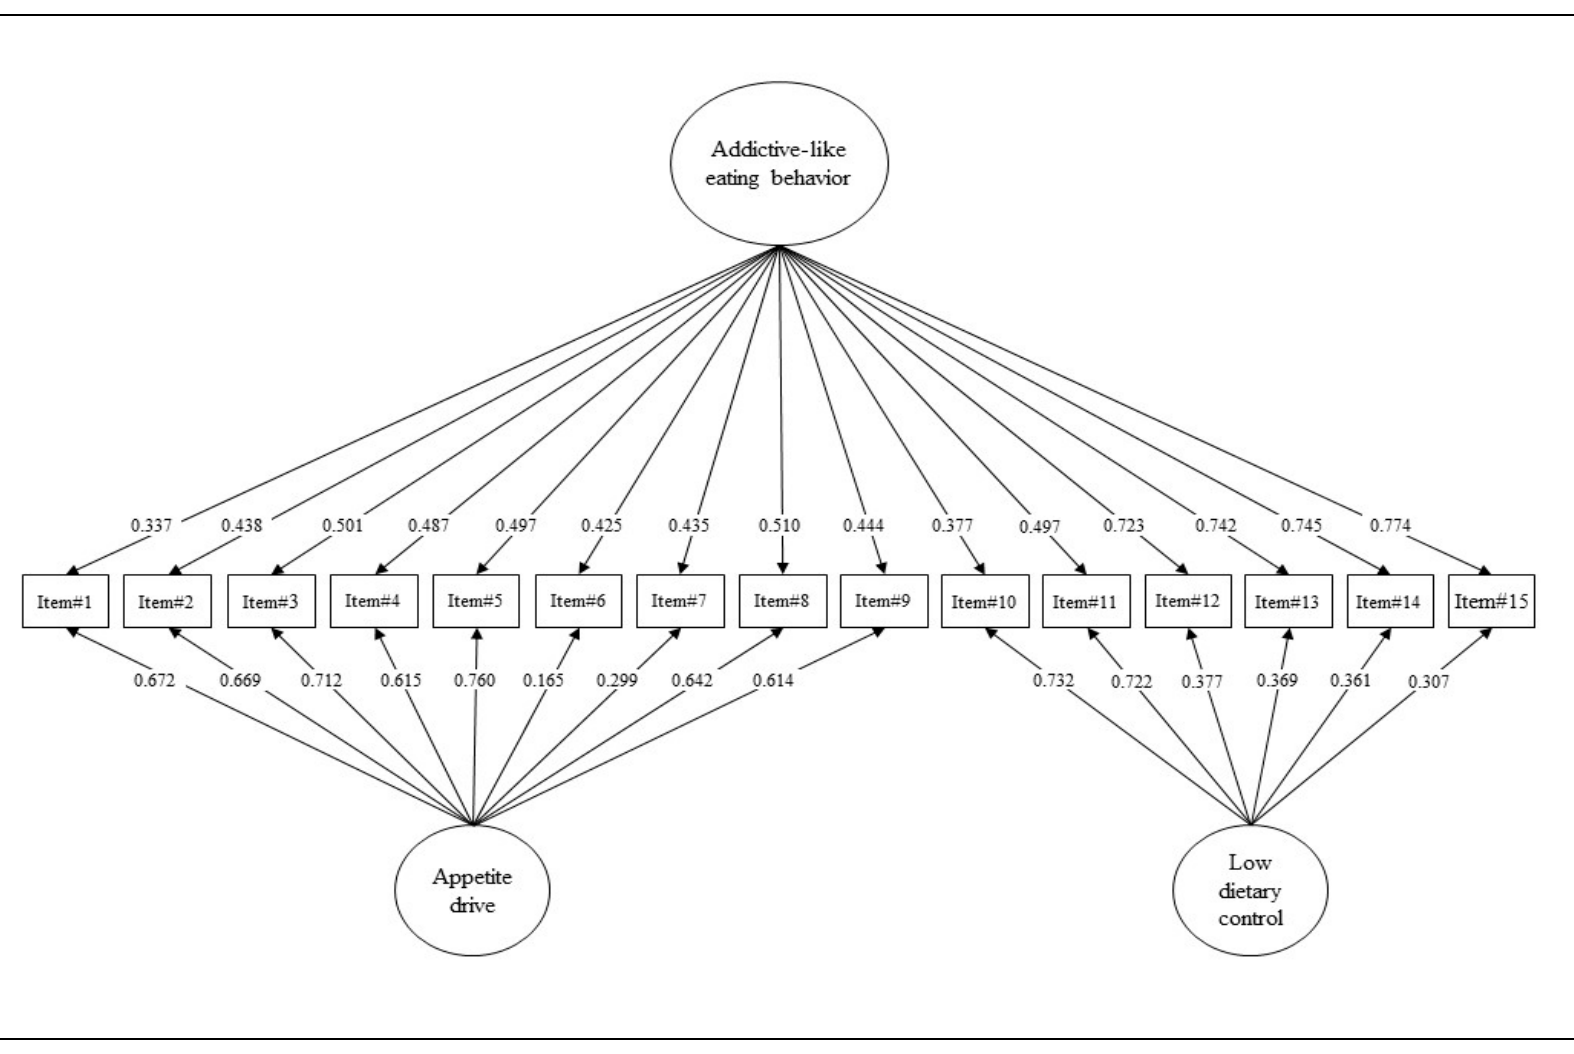
Figure 1. Structural model with factor loadings of the Italian AEBS—overall sample.